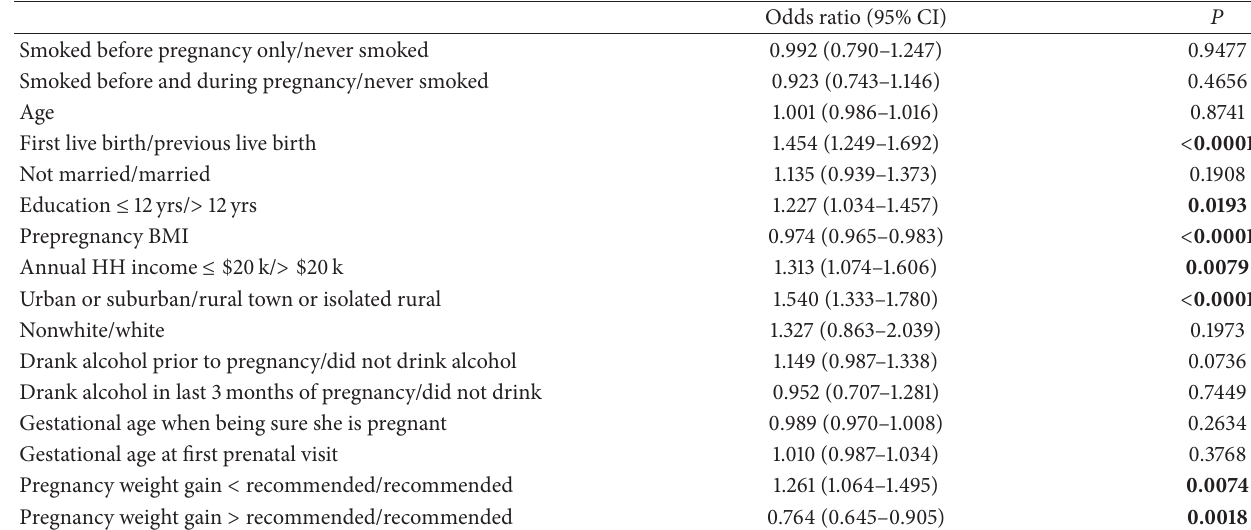
Table 1: Maternal predictors of infant admission to